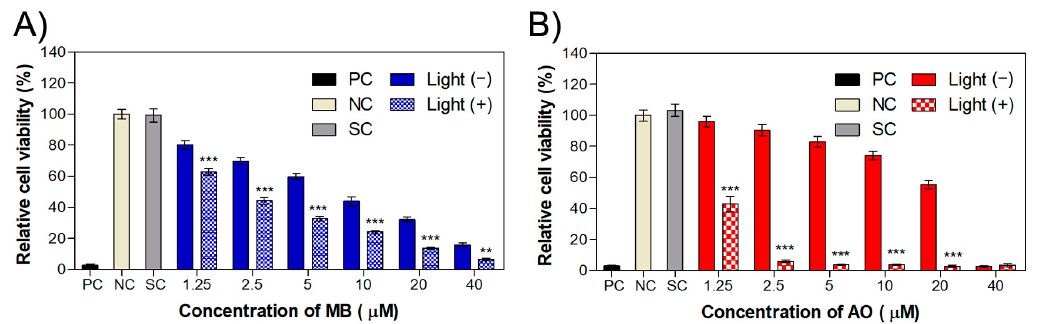
Figure 7. Relative cell viability of the WM983b cell line treated for 24 or 48 h with the dyes MB and AO within a range of concentration from 1.25 µM to 320 µM. Values are presented as the mean ± combined standard uncertainty ( n = 4), and statistical analysis comparing the results to the negative control was performed with a two-way ANOVA with Bonferroni post-test, where * p < 0.05, ** p < 0.01 and *** p < 0.001. MB: methylene blue, AO: acridine orange, PC: positive control, NC: negative control, SC: solvent control.